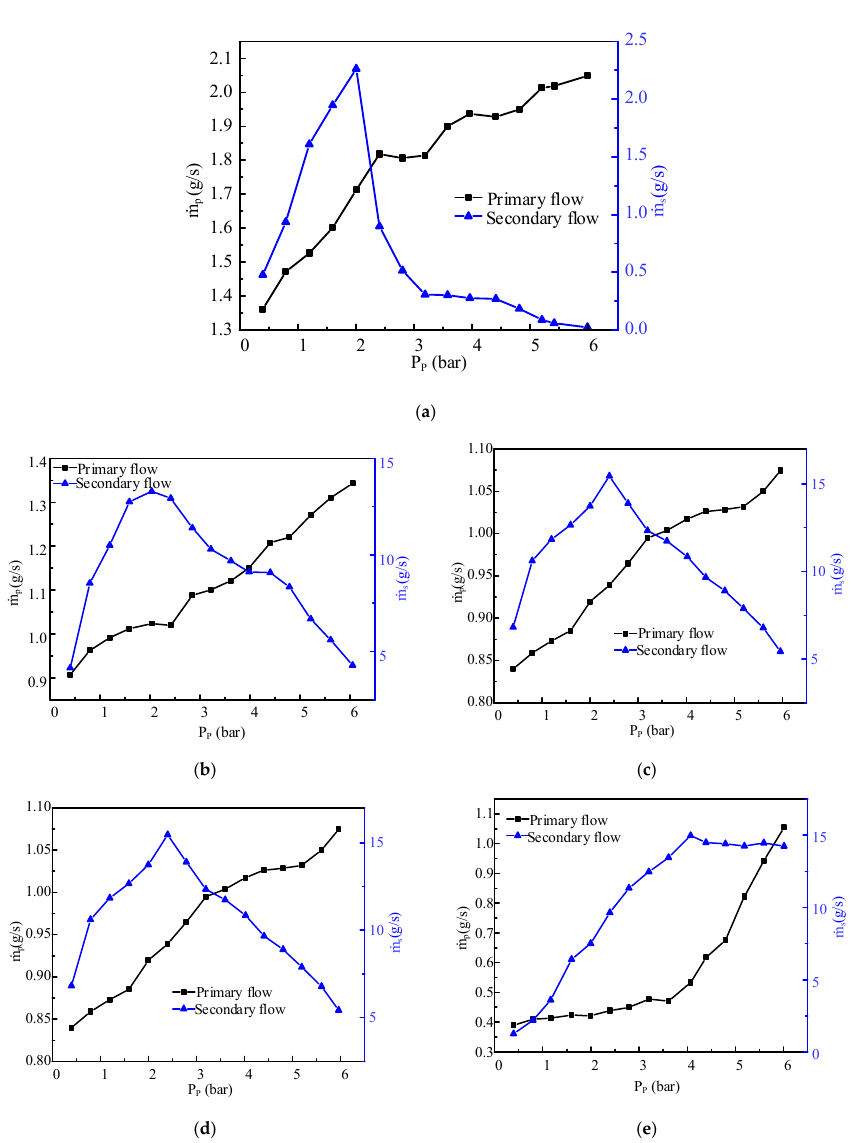
Figure 6. Effects of primary flow pressure on mass flow rates at various ARs. ( a ) AR = 2; ( b ) AR = 3; ( c ) AR = 4; ( d ) AR = 5; ( e ) AR = 6.